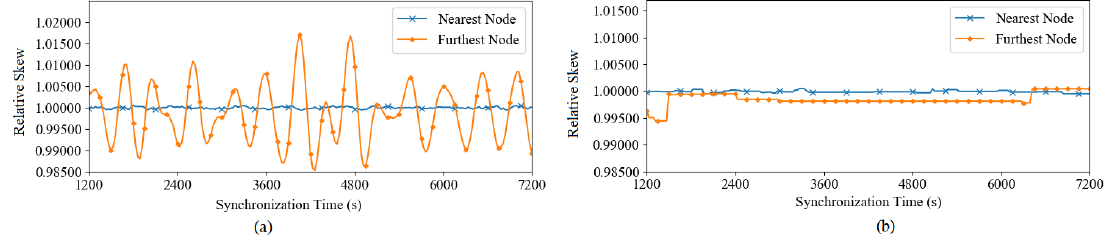
Figure 4. Relative skew of nearest node and farthest node with reference node in ( a ) FTSP and ( b ) E-FTSP with grid topology (7 ×